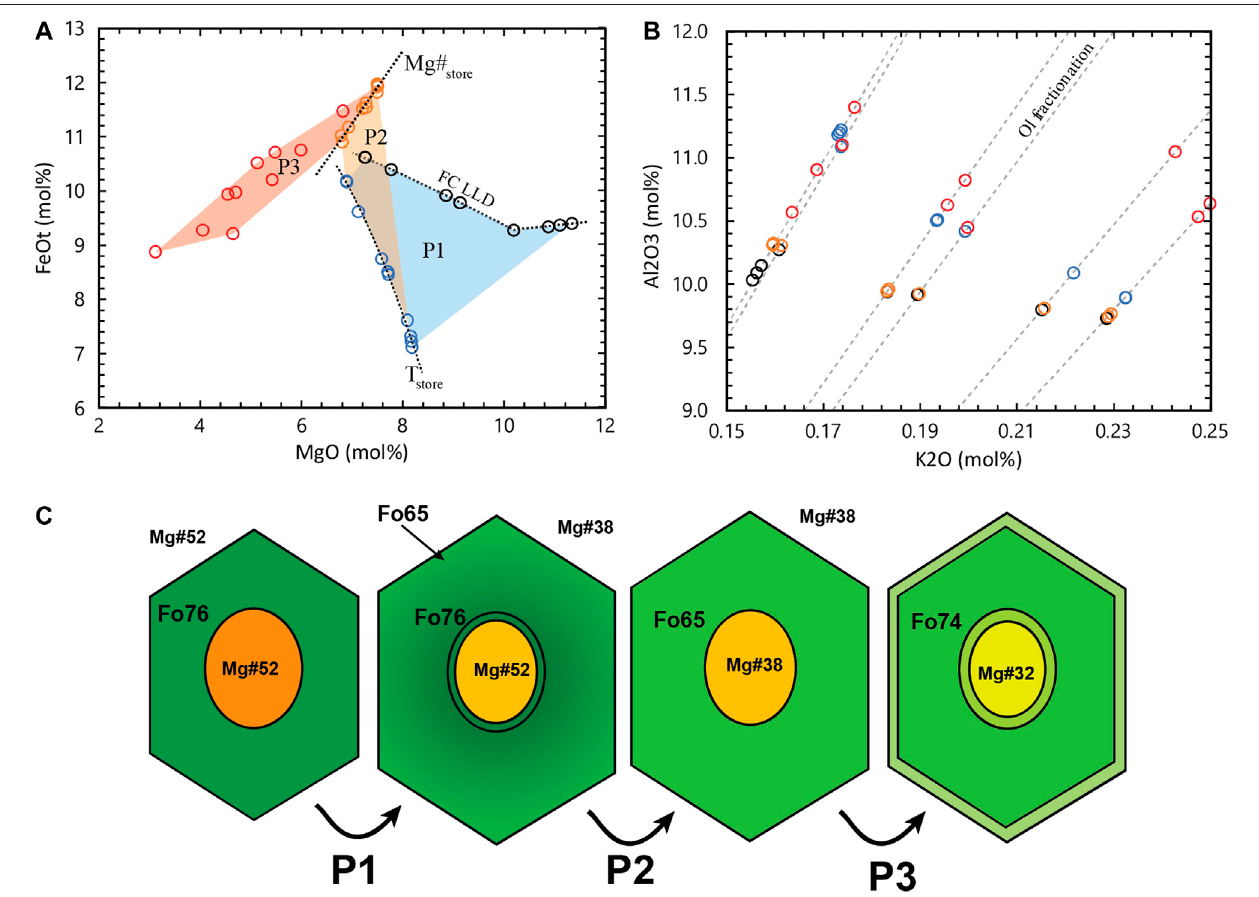
FIGURE 1 | Forward model of post-entrapment compositional changes in long stored MIs. (A) MgO vs FeOt variation diagram. Black circles are the original MI compositionstrappedduringfractionalcrystallizationofamagmabatch.BluecirclesarethecompositionoftheMIsafterP1(PECandFe-lossduringslowcooling)before reaching storage temperature T store . Orange circles are the MI compositions after P2 (re-equilibration to Mg# store ) and red circles are the fi nal MI compositions after P3 (PEC and Fe-loss during ascent and eruption). (B) K 2 O vs Al 2 O 3 variation diagram. Grey hashed lines indicate the olivine addition/subtraction trend of the MIs. Symbol colors are the same as in (A) . (C) Schematic cartoon of the evolution of one of the MIs with each phase of the post-entrapment history.